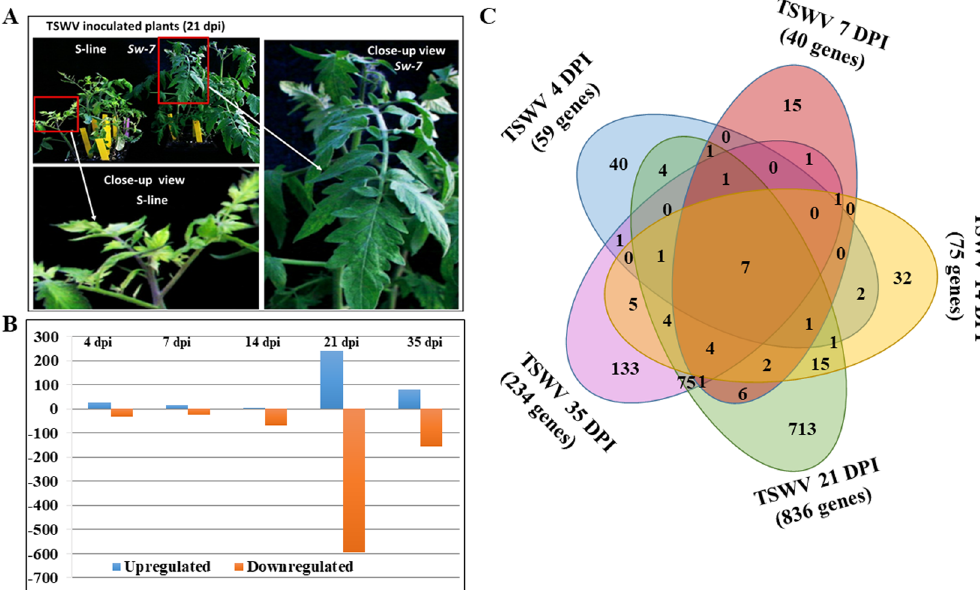
Figure 1. Differential gene expression between resistant Sw-7 line and susceptible S-line after TSWV infection. ( A ) Plants of S-line (left), and the Sw-7 at 21 days post inoculation (dpi) with TSWV (inset close view of a single leaf). ( B ) Numbers of differentially expressed genes in Sw-7 line compared to S-line at 4, 7, 14, 21 and 35 dpi with TSWV. ( C ) Venn diagram showing the numbers of common, intersecting and specific DEGs at 4, 7, 14, 21 and 35 dpi with